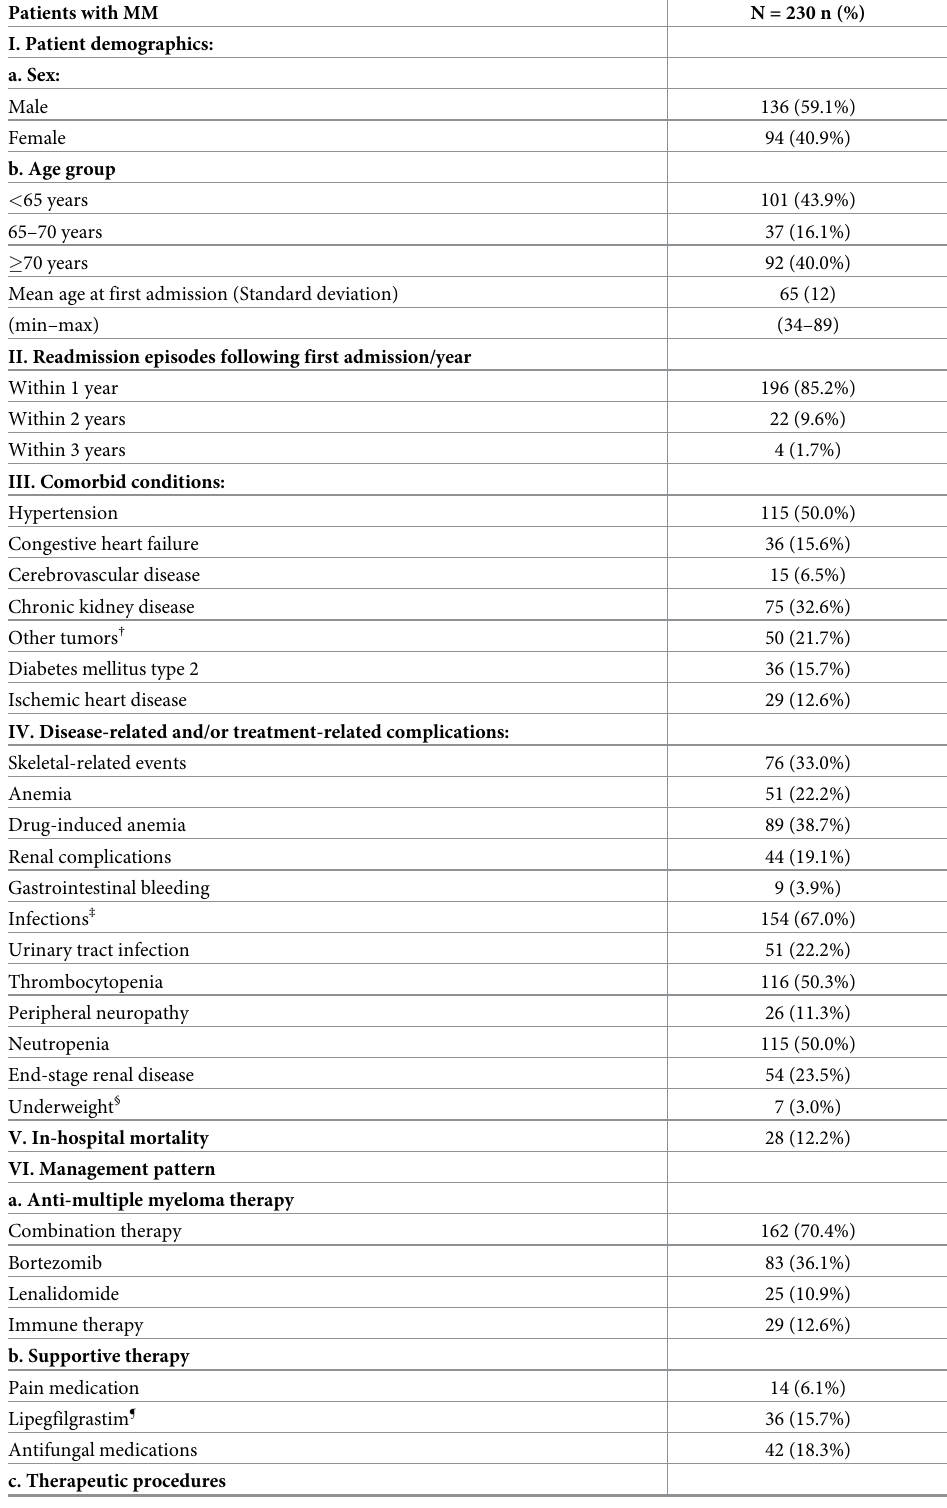
Table 2. Demographics, clinical characteristics, and management patterns of patients with multiple